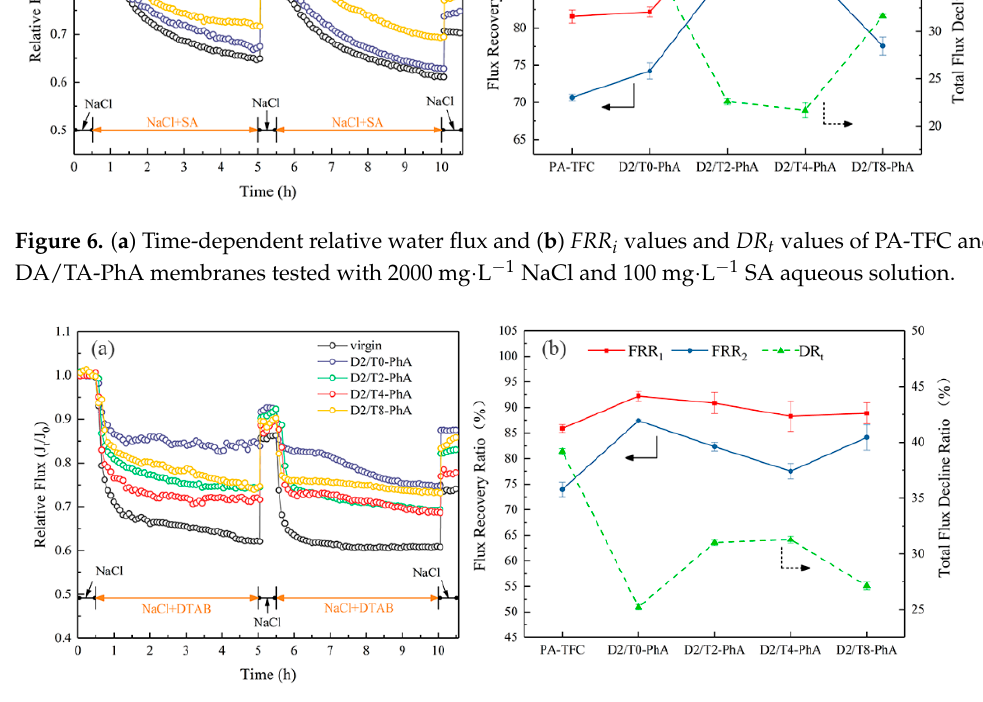
Figure 7. ( a ) Time-dependent relative water flux and ( b ) FRR i values and DR t values of PA-TFC and DA/TA-PhA membranes tested with 2000 mg·L − 1 NaCl and 50 mg·L − 1 DTAB aqueous solution.